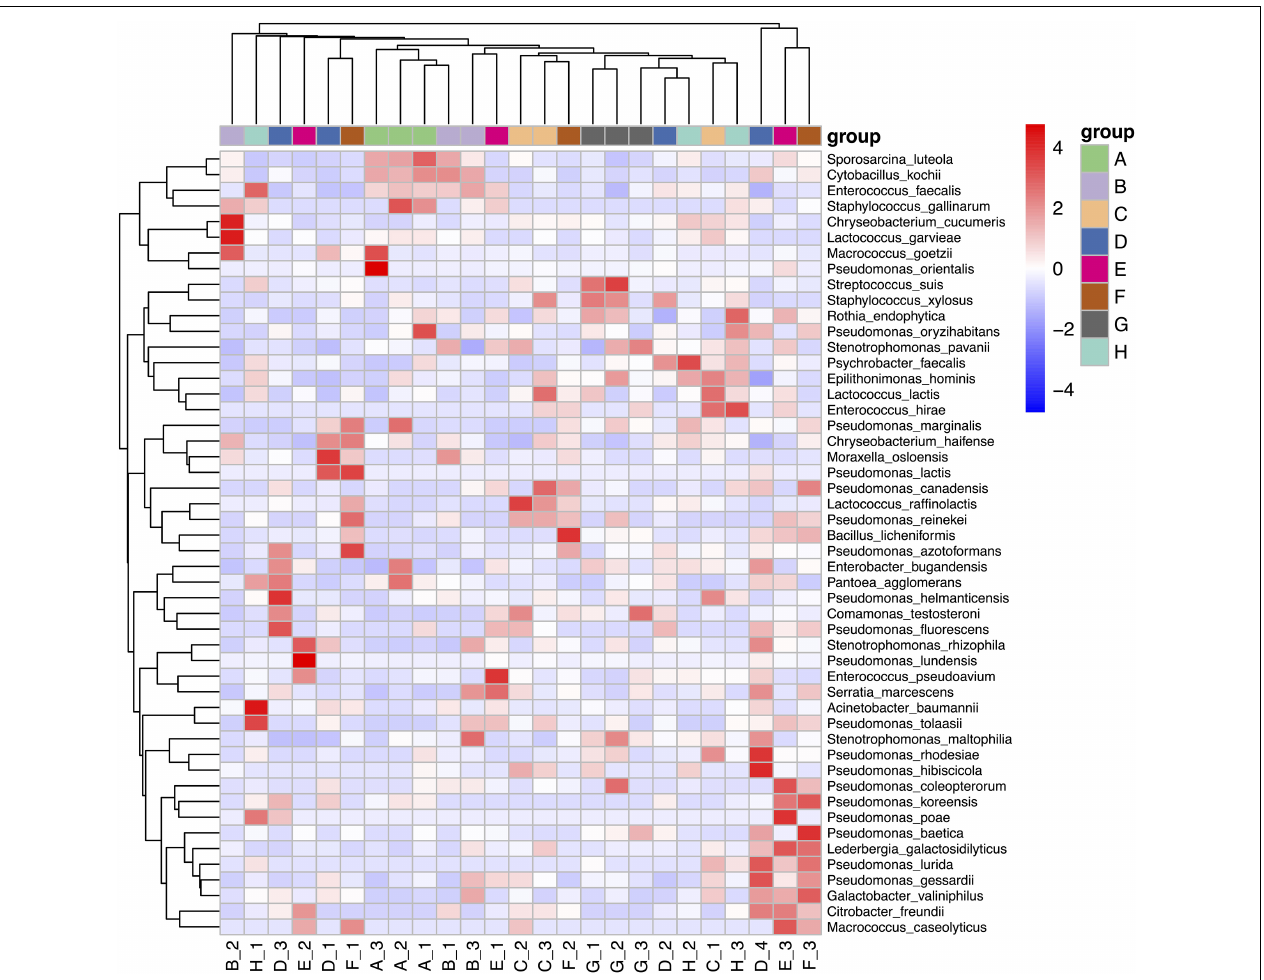
FIGURE 4 | Heatmap analysis of raw milk samples used in this study. A. Heilongjiang, B. Inner Mongolia, C. Gansu, D. Henan, E. Anhui, F. Jiangsu, G. Chongqing, and H. Hunan.